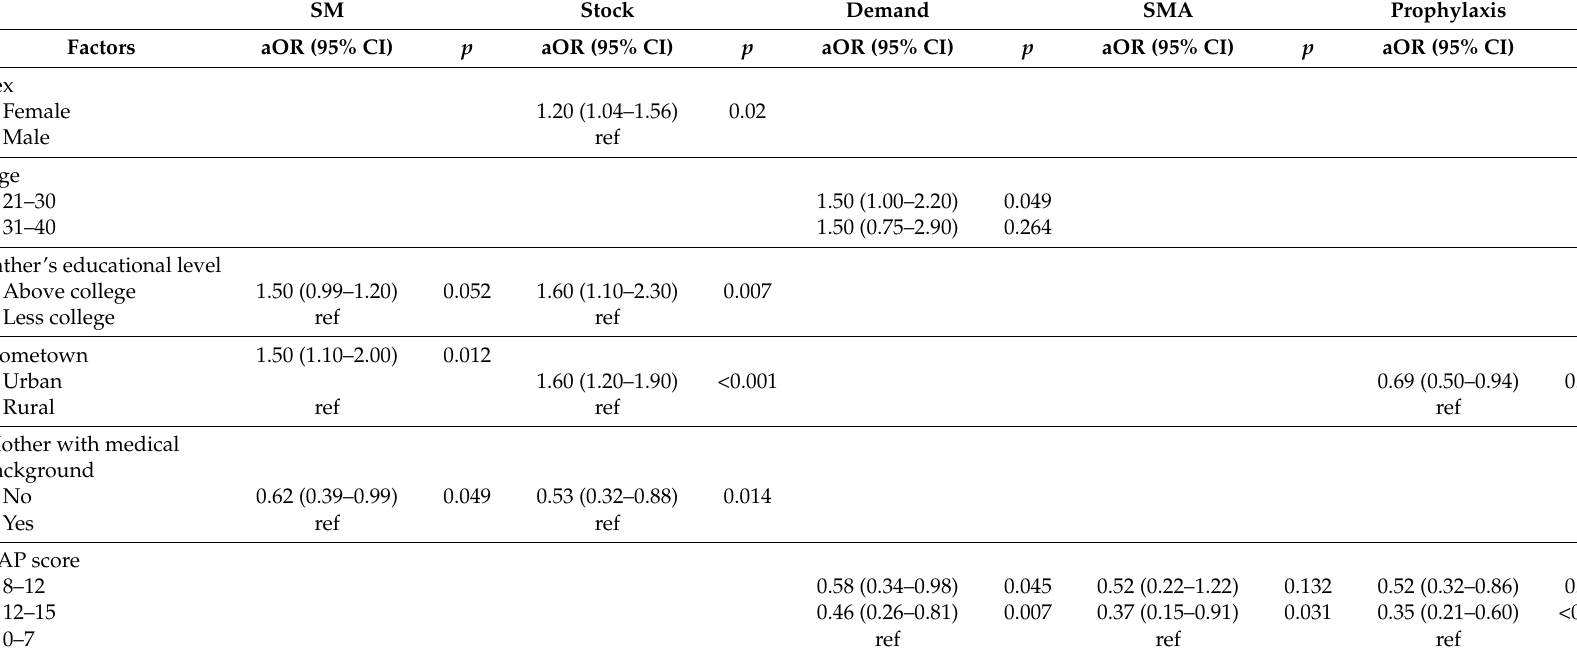
Table 5. Logistic regression for the characteristics associated with the five behaviour outcomes among medical students in China in